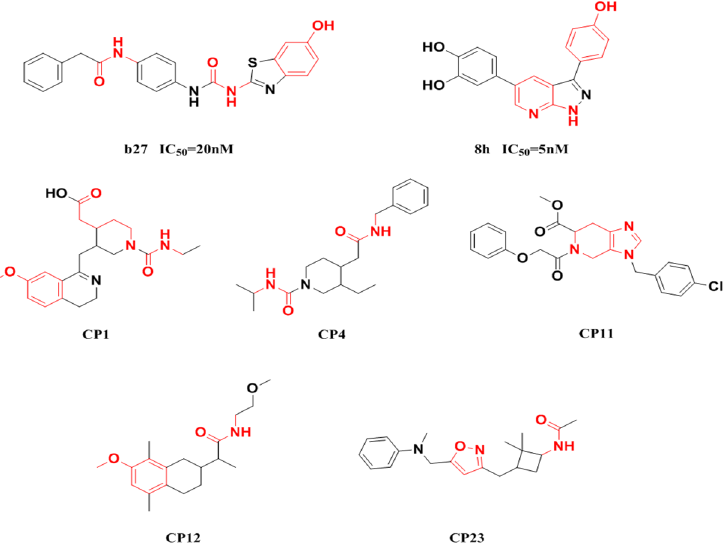
Figure 4. Pharmacophoric fragments presented in the DYRK1A inhibitors (b27 and 8 h) and theo- retical hits.